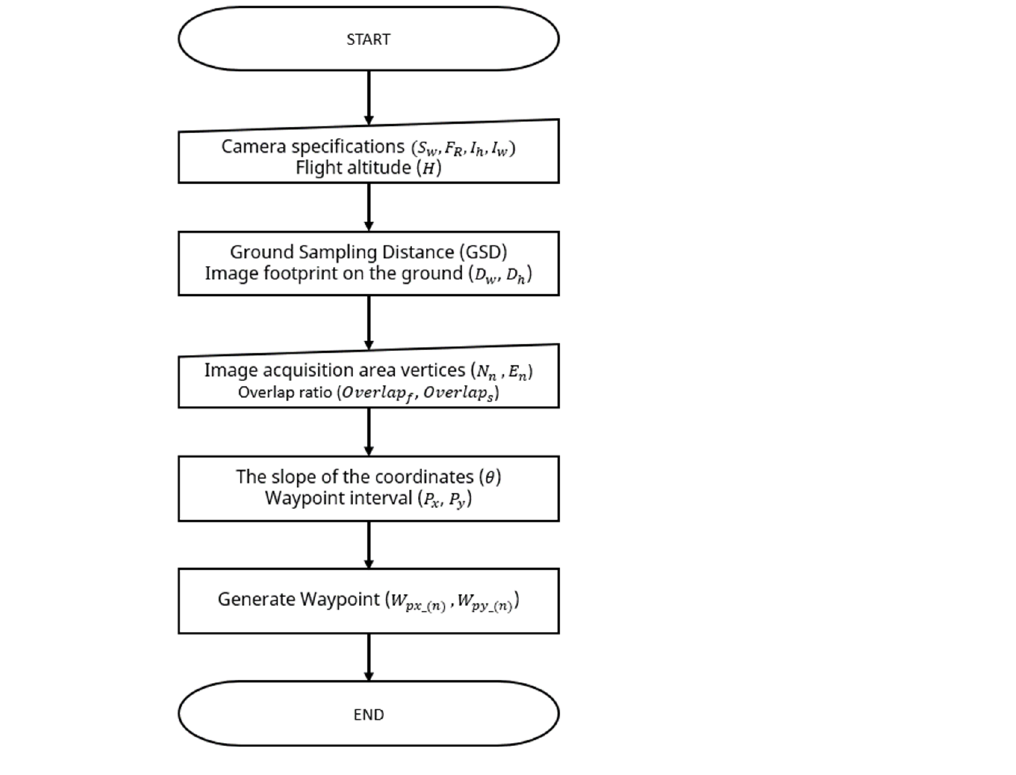
Figure 4. Flowchart of the path generation algorithm for the collaborative driving system. Table 1. Input variables required for path generation.